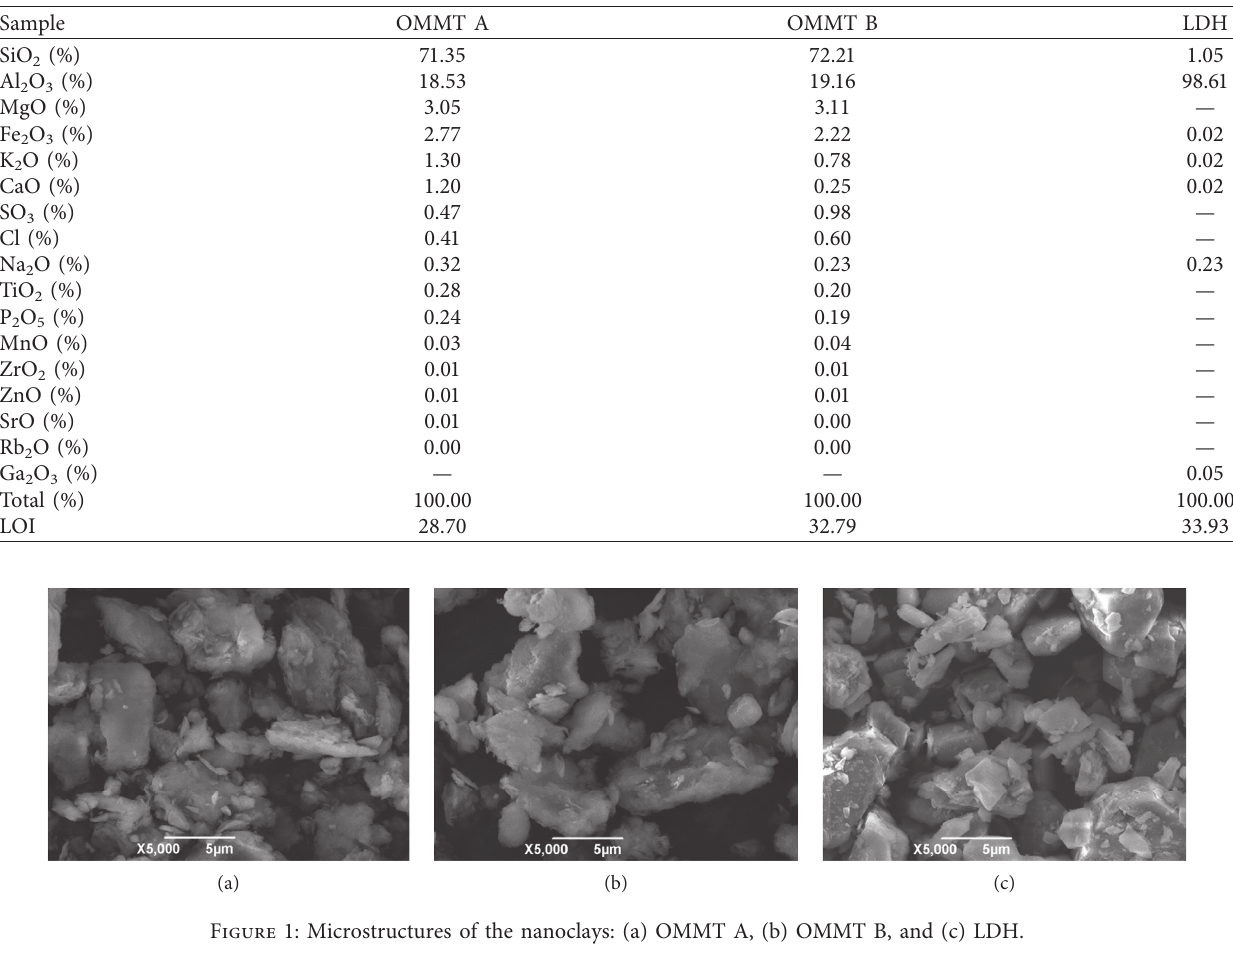
Table 1: Specific compositions of the nanoclays.